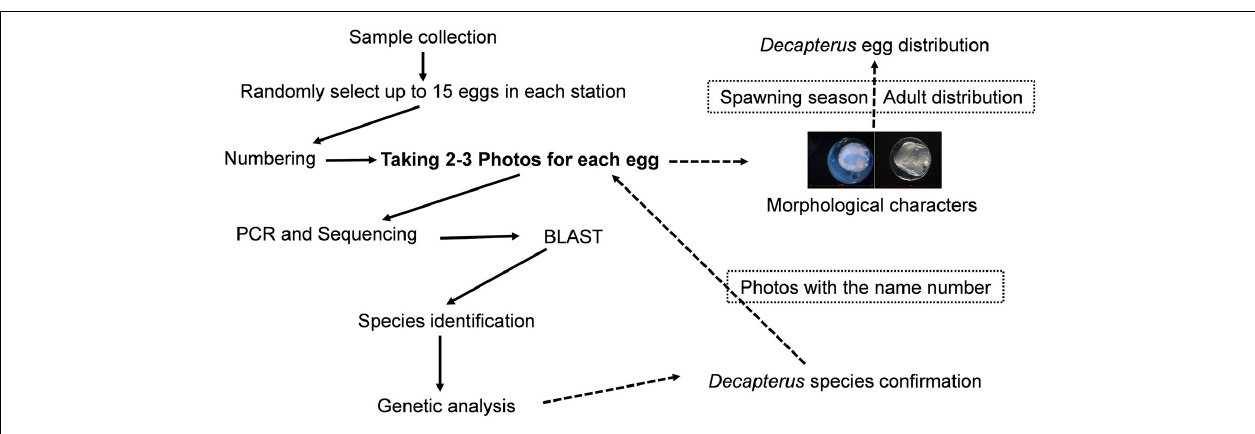
FIGURE 2 | Research